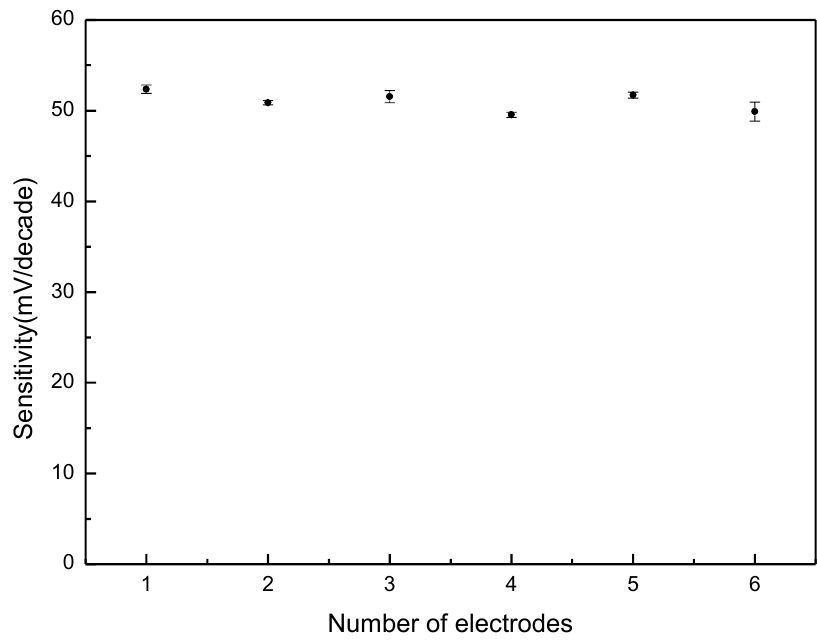
Fig. 4 Repeatability of six HA sensors Figure 5. Repeatability of six histamine sensors in histamine solutions (10 − 7 –10 − 1